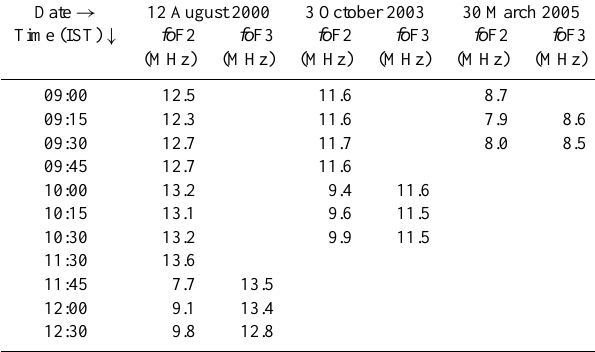
Table 1. Variation in the critical frequencies of the F2 ( fo F2) and F3 ( fo F3) layer for the days shown in Fig.